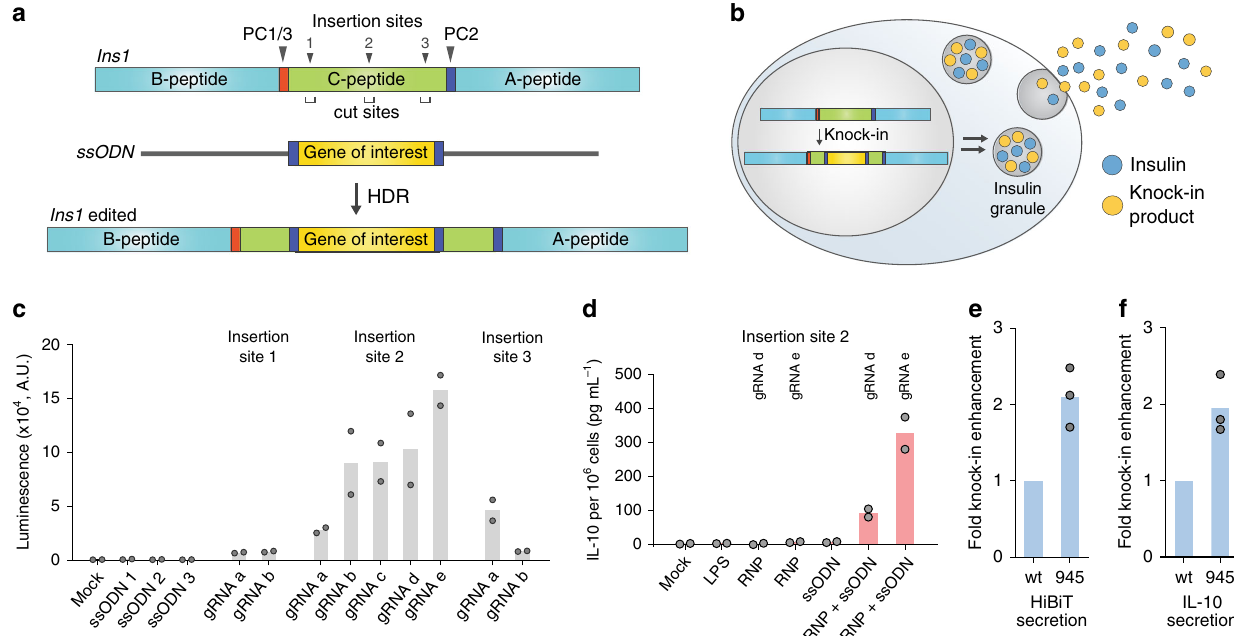
Fig. 5 Ef fi cient engineering of INS-1E cells for secretion of exogenous peptides and proteins. a Schematic of genome editing in the Ins1 locus of INS-1E cells. PC, prohormone convertase. HDR, homology-directed repair. b Engineered cells can secrete exogenous gene products together with insulin. c INS-1E cells were engineered to secrete the 11-residue HiBiT peptide. Multiple gene insertion sites and DNA break sites were investigated ( n = 2 biologically independent experiments). A.U. arbitrary unit. d INS-1E cells were engineered to secrete interleukin 10 (IL-10), ( n = 2 biologically independent experiments). LPS lipopolysaccharide. RNP ribonucleoprotein. e , f Display of ssODN on Cas9 enhanced the secretion of e HiBiT peptide and f IL-10 ( n = 3 biologically independent experiments). Source data are provided as a Source Data fi